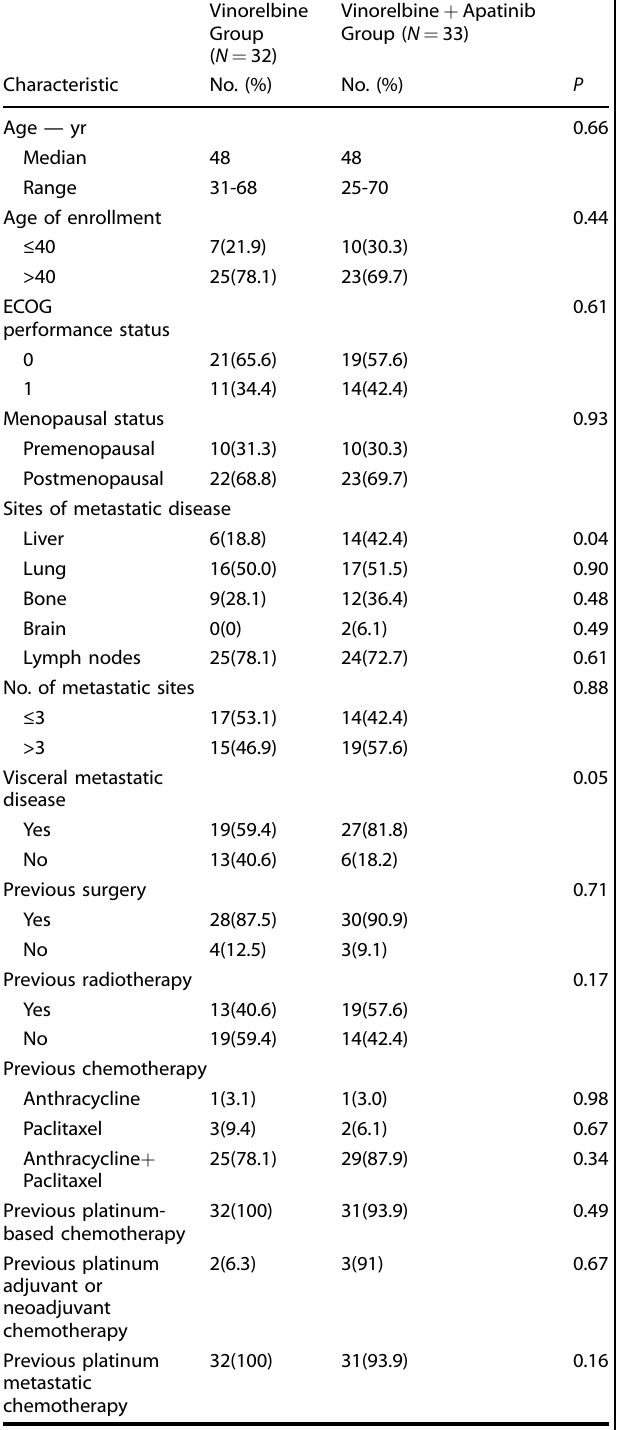
Table 1. Baseline characteristics of the patients.